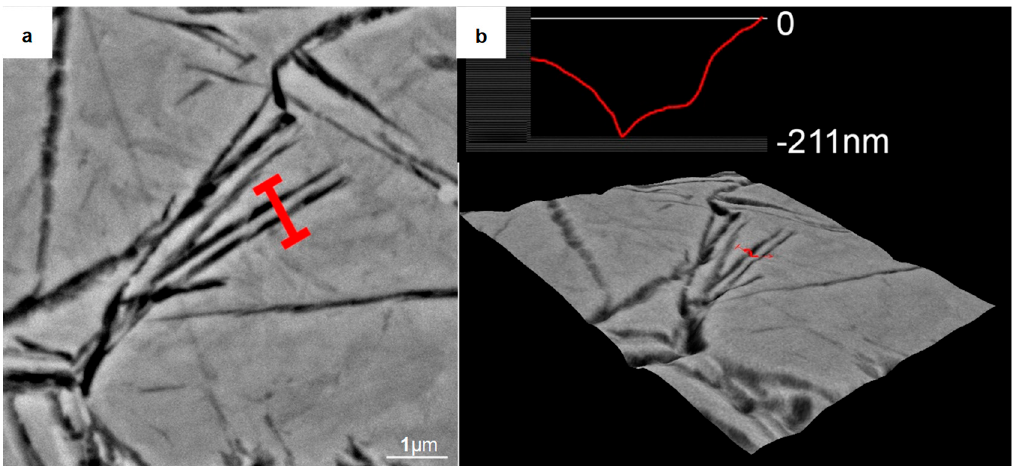
Figure 4. Analysis of the nanocrystalline structure formed in the sample quenched at 280 °C after deep etching by a 4% nitric acid alcohol solution. ( a ) Backscattered electron image of the analysis area; ( b ) Size analysis by the 3D Roughness Reconstruction software. It indicates that the nanocrystalline structure had a size of about 200 nm in the height direction.